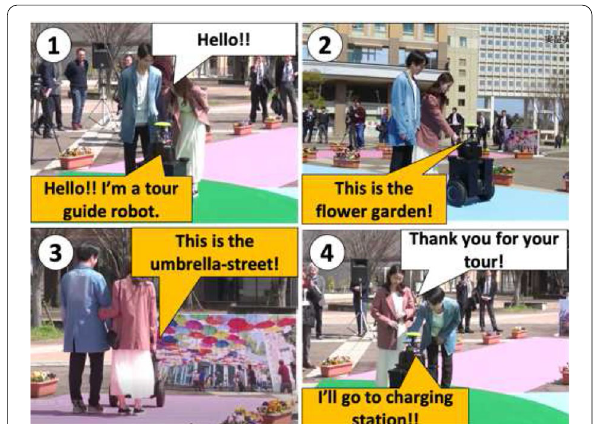
Fig. 26 Experiment with the voice recognition system